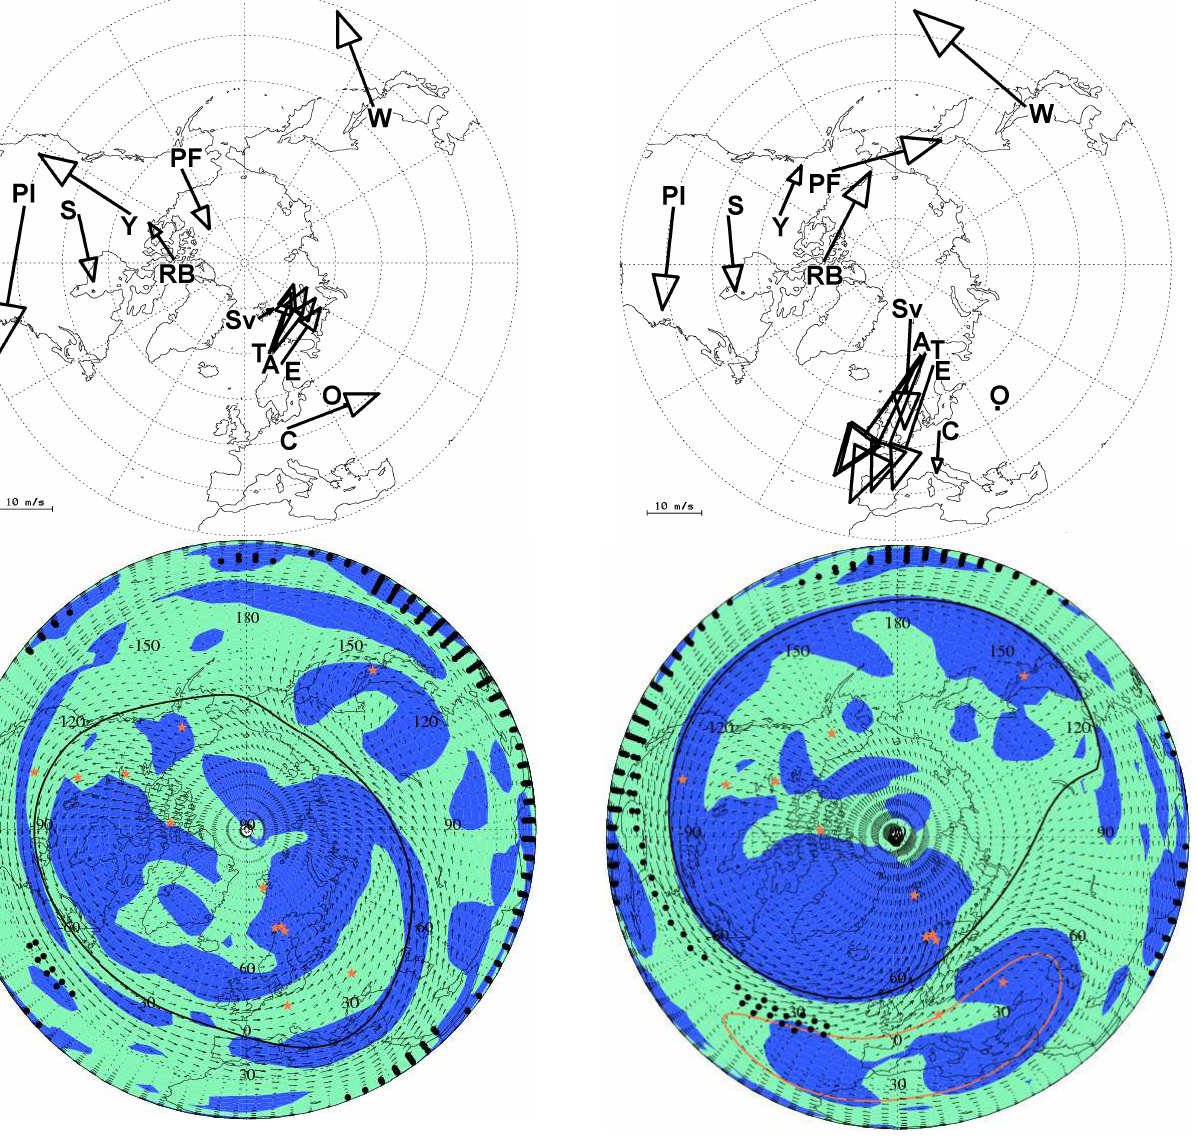
Fig. 8d. The same as Fig. 8a, but for 19 February